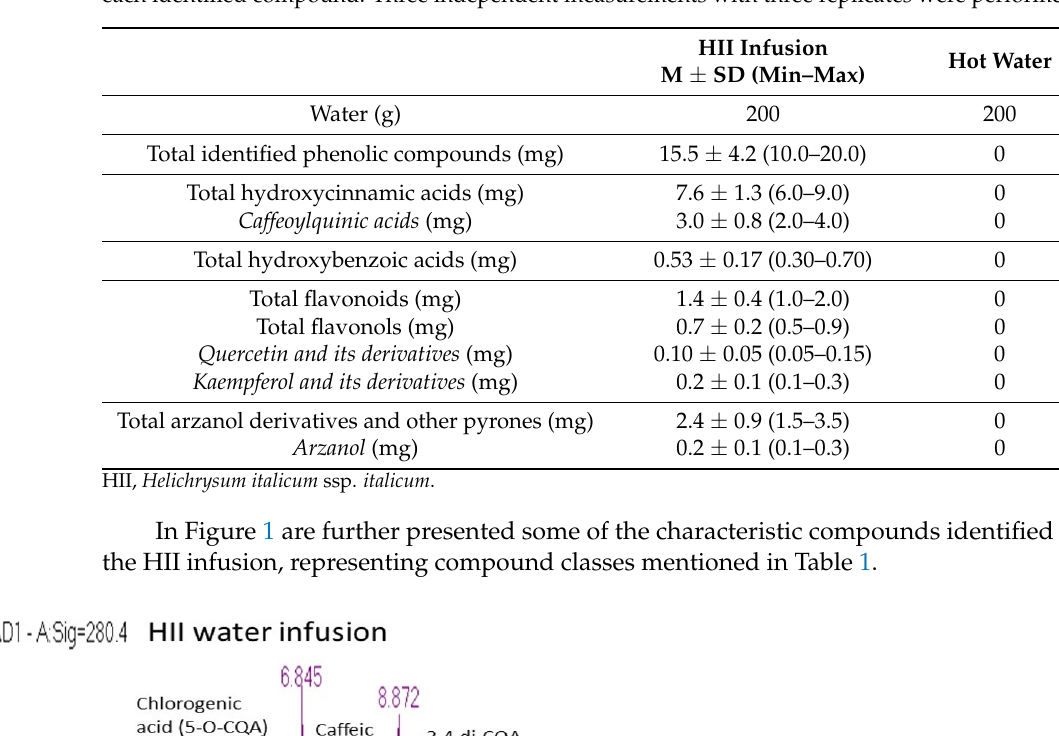
Table 1. Composition of the HII infusion. The estimated mean (M) ± standard deviation (SD), and minimum (Min) and maximum (Max) values of compound classes and subclasses (written in italic) were quantified based on the determined total phenolic content and relative abundance values of each identified compound. Three independent measurements with three replicates were performed.